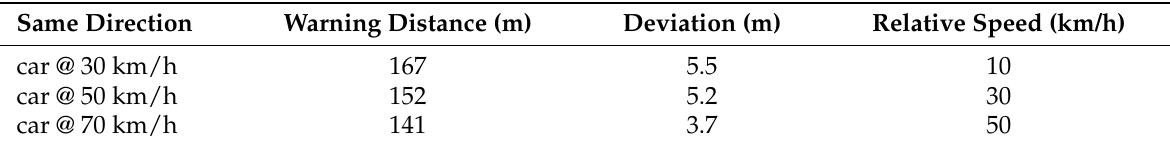
Figure 18. Image with distances for the worst case (car and bicycle in opposite directions with a relative speed of 90 km/h). The green line is the alarm threshold (150 m)l the orange line shows the distance when the alarm pops up (121 m); the blue line is the car breaking distance (31 m); and finally, the purple line is the remaining distance when the two vehicles are stopped (88 m). Note that the reaction time in the experiment is quite reduced because the driver is waiting for the alarm. Table 1. Distance at which the alarm is displayed when the vehicles moves in the same